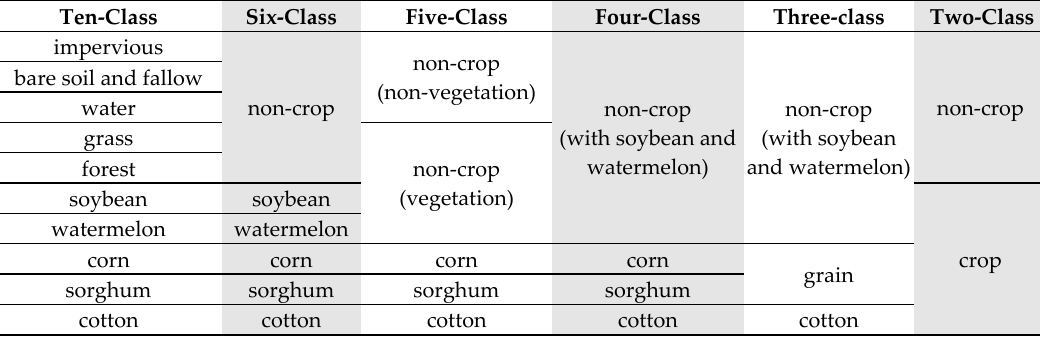
Table 1. Definition of six different class groupings for image classification.